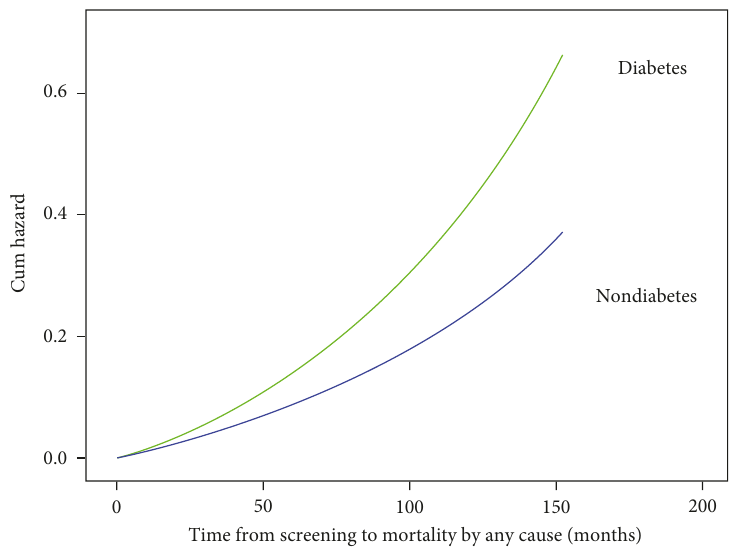
Figure 2: Cumulative hazard plot of the Cox proportional analysis in individuals with or without diabetes.